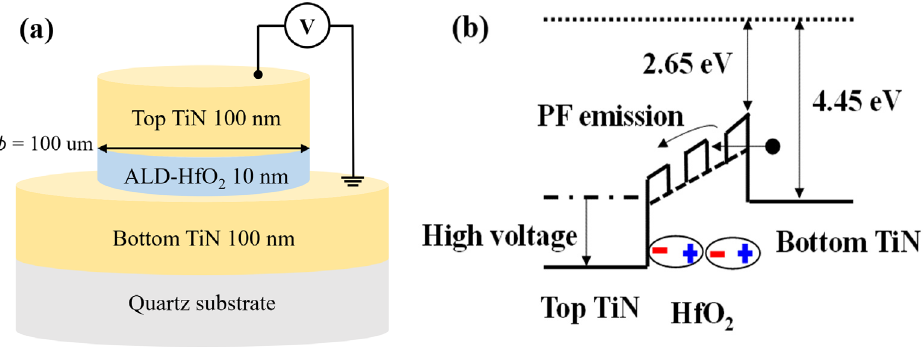
Figure 1. ( a ) Schematic of the fabricated HfO 2 -based MFM capacitor. ( b ) Illustration of the transport mechanism in the MFM device with an applied voltage.